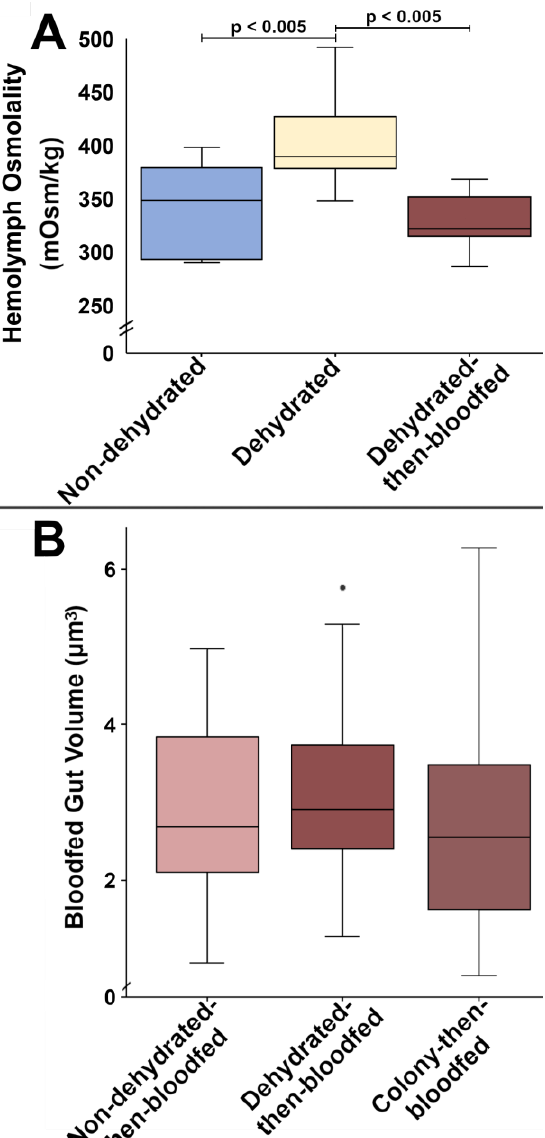
Figure 3. Hemolymph osmolality and bloodfed midgut volume for A. aegypti subjected to various treatments. ( A ), hemolymph osmolality for non-dehydrated (N1), dehydrated (N7), and post-dehydration bloodfed (Y7) A. aegypti (N = 30); ( B ), midgut size comparisons for bloodfed A. aegypti after 18 h of exposure to non-dehydrating (Y1), dehydrating (Y7), or colony conditions (N = 86). Significance was determined via ANOVA and Tukey’s HSD test.